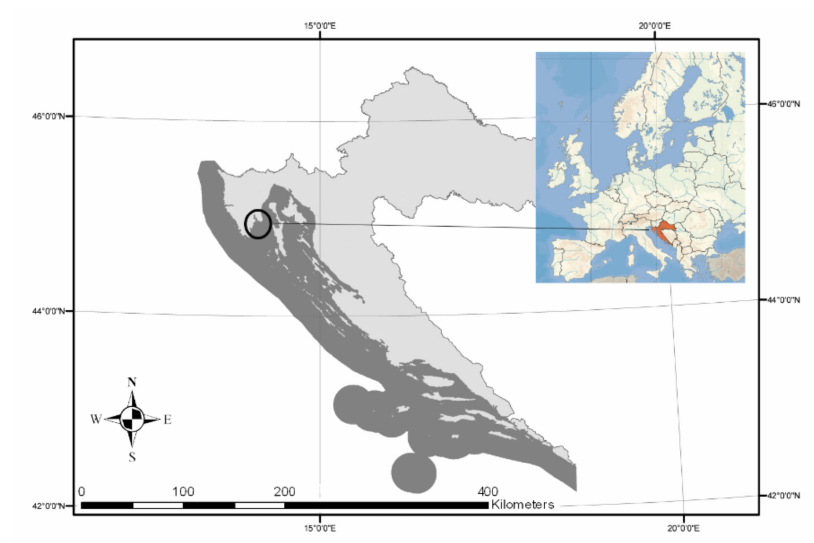
Figure 1. Sampling location in the Adriatic Sea,